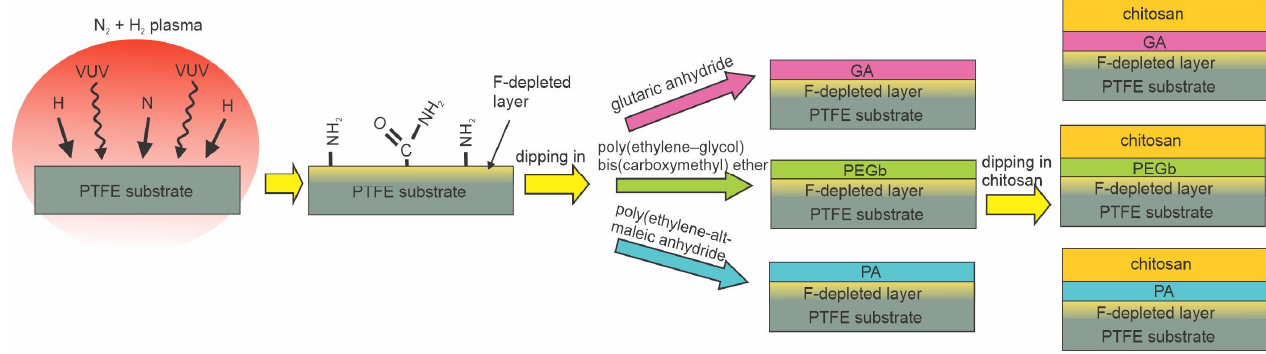
Figure 15. Immobilization of chitosan on polytetrafluorethylene.